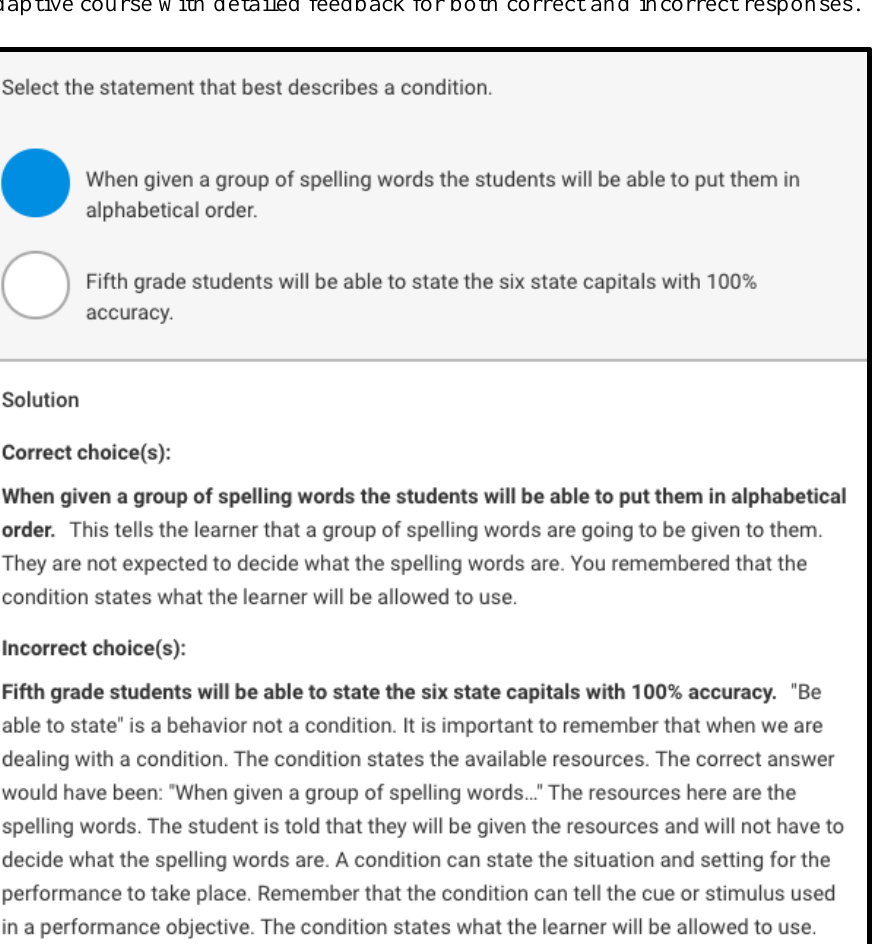
Figure 4. Detailed feedback for each assessment item. Adapted from EME6613: Instructional Systems Design , by B. Chen, 2019, Orlando, FL: University of Central Florida. Copyright 2019 from the University of Central